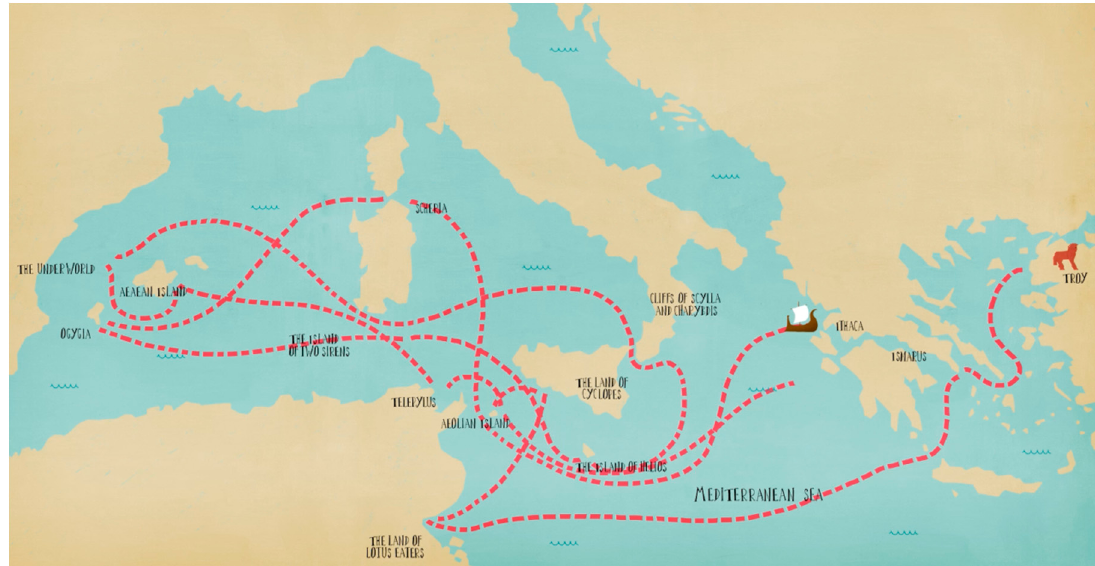
Figure 1. The journey of Odysseus. 0: Troy; 1: Ismarus; 2: The land of the Lotus-eaters; 3: The land of the Cyclopes; 4: The Aeolian island; 5: Telepylus, the city of the Laestrygonias; 6: Aeagean island (Circe’s island); 7: The Underworld (The house of Hades); 8: The island of the two Sirens; 9: Cliffs of Scylla and Charybdis; 10: The island of Helios; 11: Ogygia (Calypso’s island); 12: Scheria (island of the Phaeaians); 13: Ithaca.